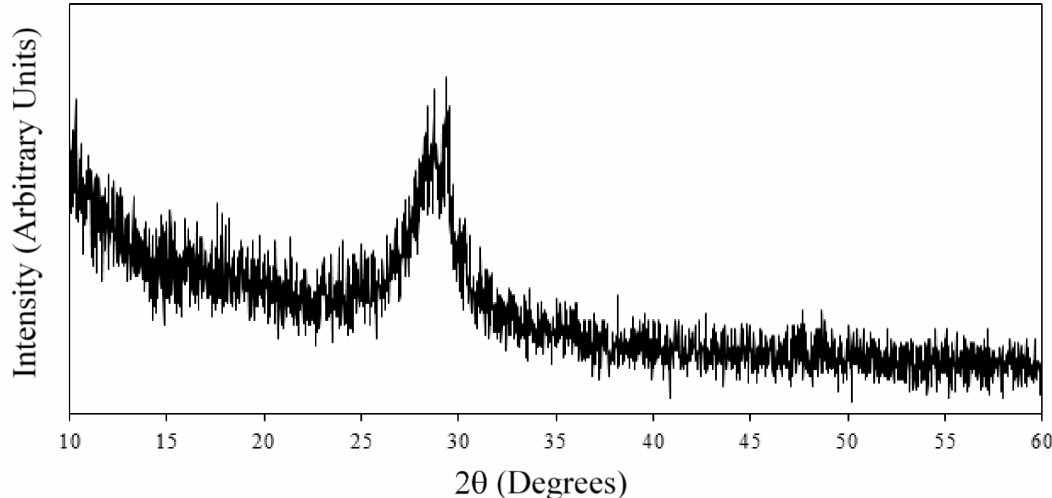
Figure 3. XRD spectrum of the PEI/PSS-CSH sample with three bilayers deposited on a silicon wafer substrate.